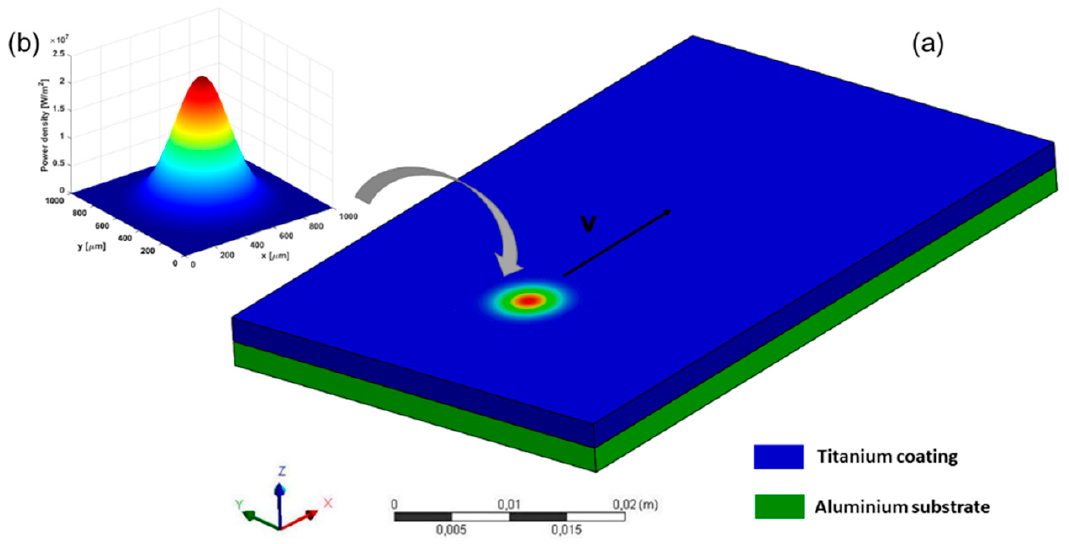
Figure 1. ( a ) 3D numerical model and ( b ) Gaussian laser distribution.